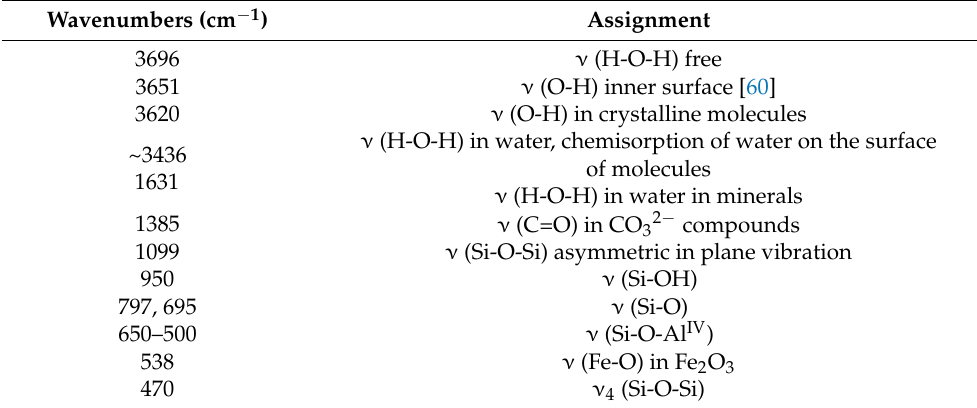
Table 4. Assignments of the major absorption bands of tested diatomaceous earth